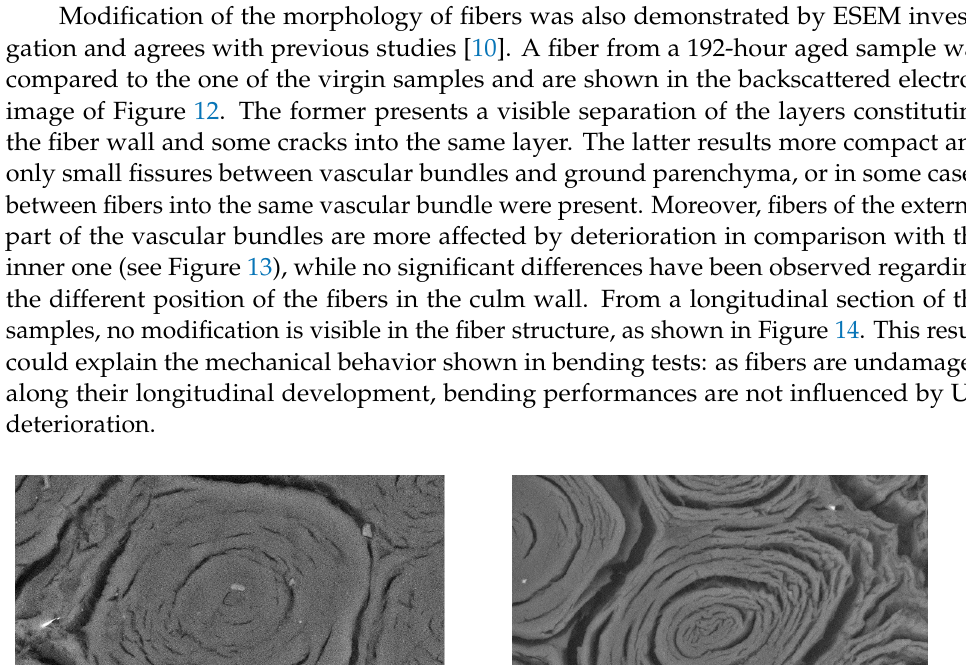
Figure 11. ATR FTIR spectra of unaged and UV (360 h) aged natural ( a ) and treated ( b ) samples.